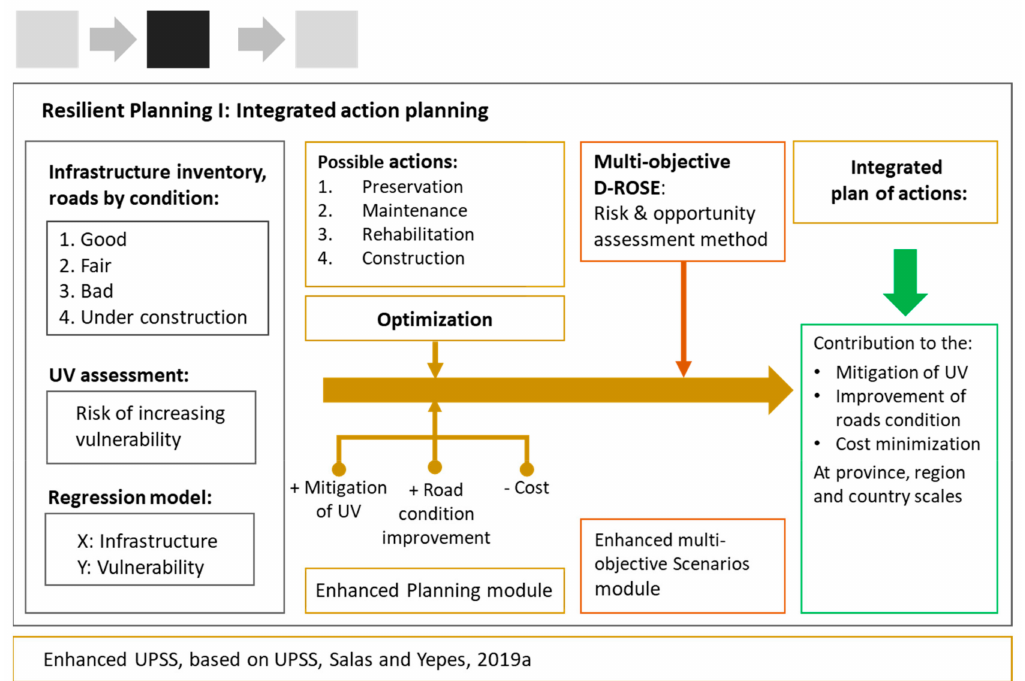
Figure 3. Step 2: planning of actions and action risk